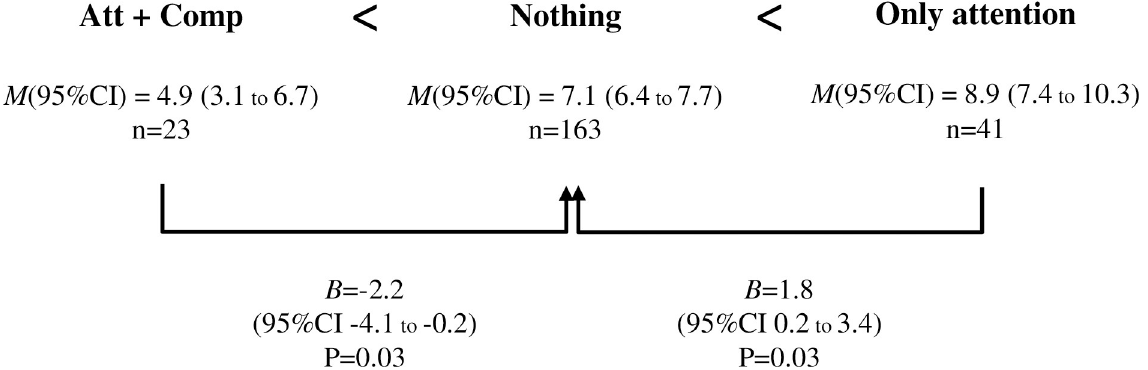
Fig 2. Effect sizes of each insight category on somatic complaints taking Low attention + Low comprehension as the reference category. Mean frequencies of somatic complaints within insight positions and effect sizes of each insight category on somatic complaints taking Low attention + Low comprehension as the reference category, and controlling for age, sex, SES, neuroticism, anxiety and depression. Notes: High attention and High comprehension (Att + Comp); Low attention and Low comprehension (Nothing); High attention but Low comprehension (Only attention). Adjusted mean ( M ); Linear regression coefficients ( B ), 95% mean confidence intervals (95% CI), and p values (P).